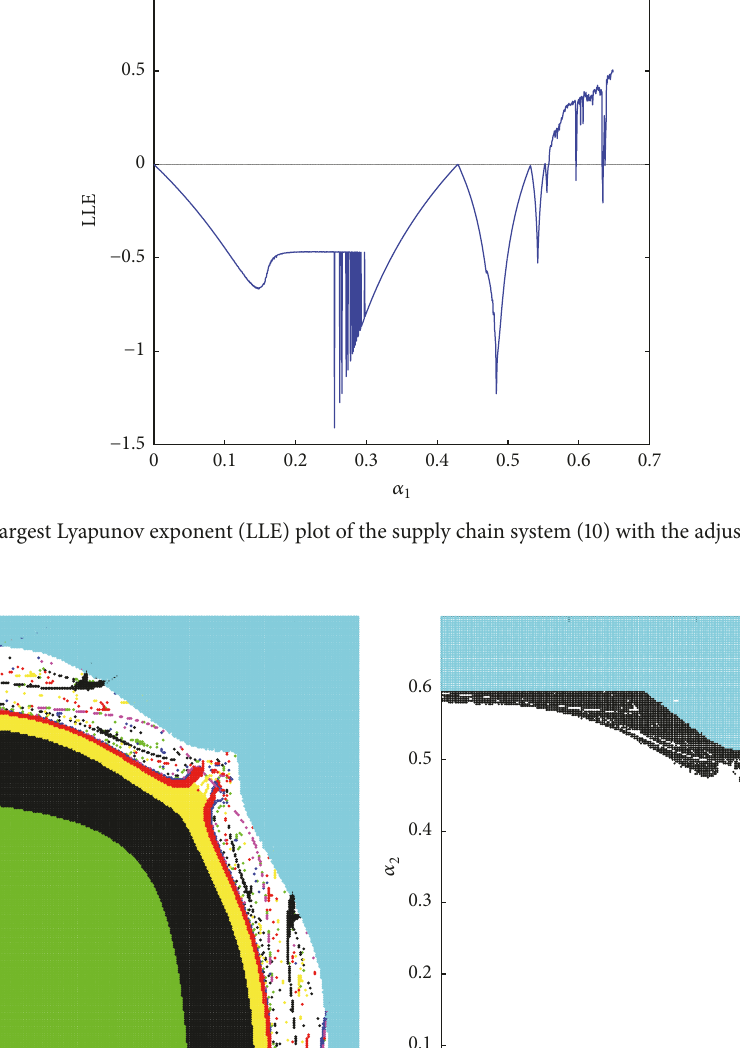
(𝑡)) + (1 + 𝑘 𝑛 (𝑡)) (1 + 𝑘 ⋅ (𝑎 − 𝑏 (1 + 𝑘 1 1 1 (𝑡) − 𝑝 (𝑡 + 1)) + 𝐾 (𝑝 1 𝑟 𝑟 𝑘 (𝑡 + 1) = 𝑘 (𝑡) + 𝛽𝑘 (𝑡) (𝑝 𝑛 𝑛 𝑛 (𝑡)) 𝑝 (𝑡))) + 𝐾 ⋅ (𝑐 − 2 (1 + 𝑘 𝑛 𝑛 𝑟 (𝑡 + 1)) − 𝑘 𝑛